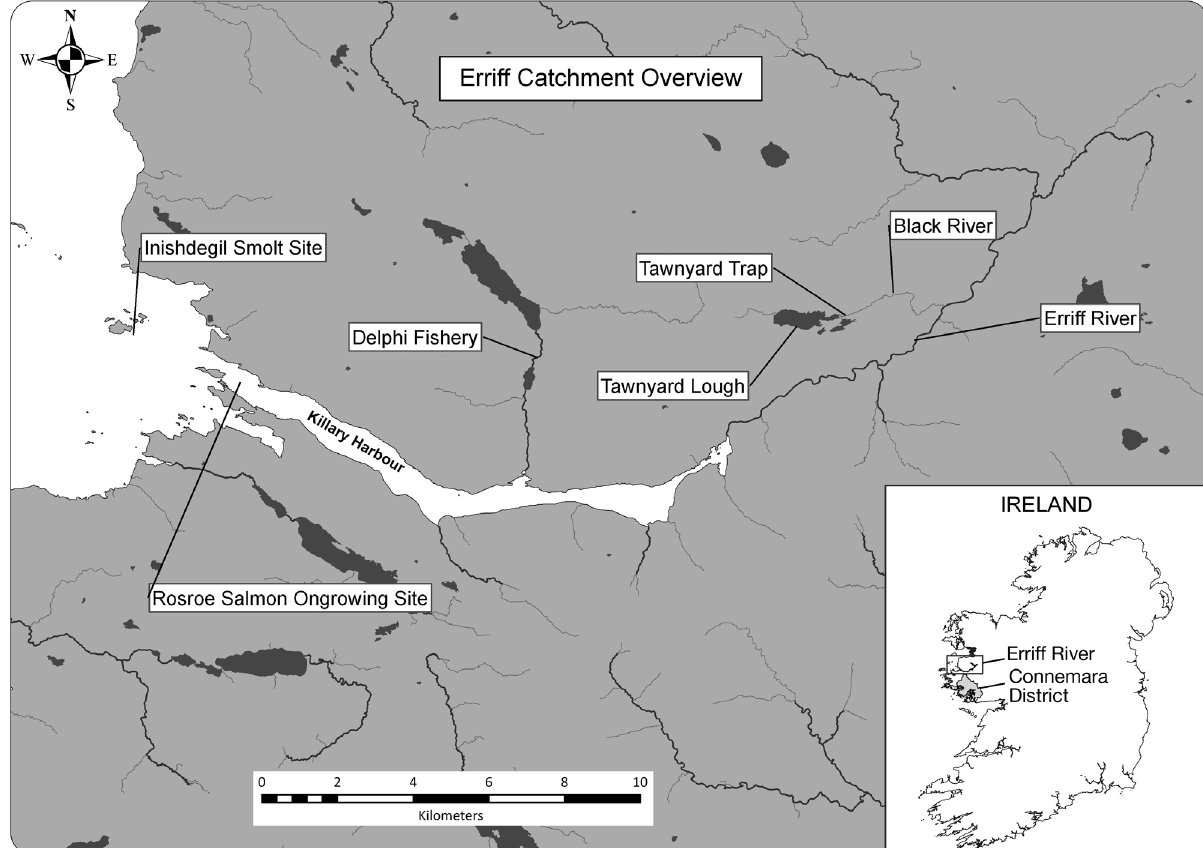
Fig. 1. Erriff Catchment and Killary Harbour Overview, western